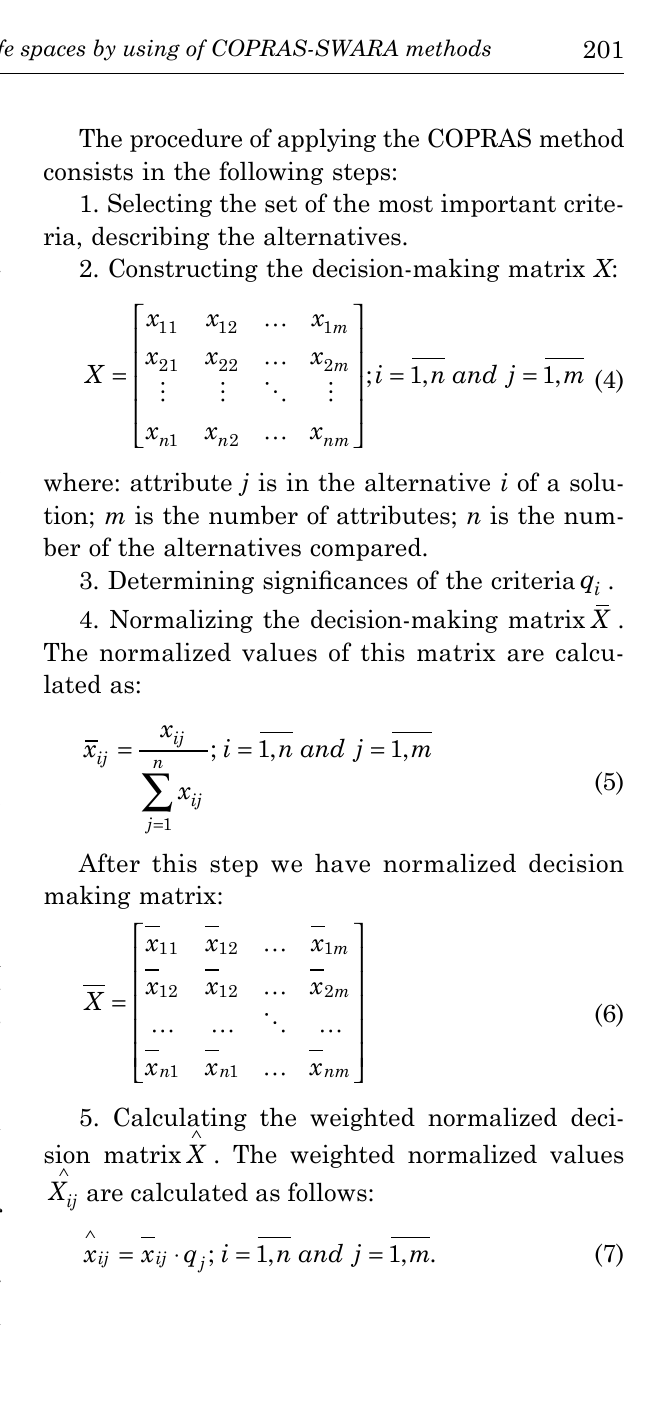
Table 3. Recent developments of decision making models based on COPRAS